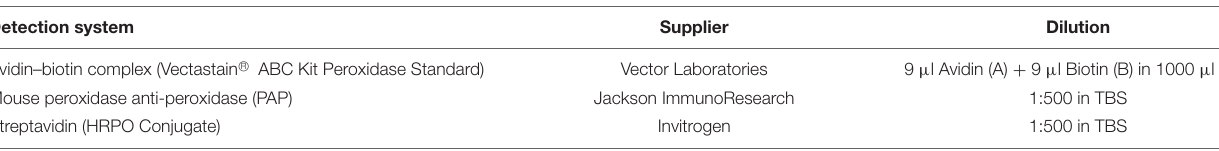
TABLE 3 | Detection systems used in immunohistochemistry. Detection